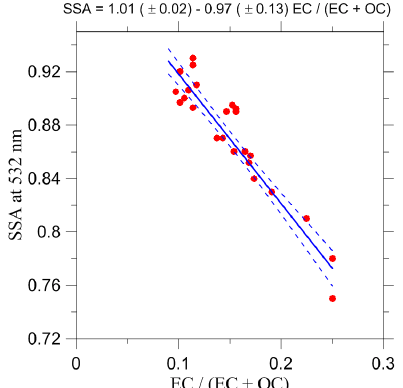
Figure 1. The relationship between the EC/(EC + OC) ratio and SSA at 532 nm. The relationship has been obtained in this study by using the data of aircraft measurements of SSA, BC and PM 2.5 in aging BB plumes [70] (see Figure 9b in ref. [70]). The EC/(EC + OC) ratio has been derived from the measurement data for the Δ BC/ Δ PM2.5 enhancement mass ratio by assuming that the BC measurements were representative of the EC content in BB aerosol and that OC mass fraction of the PM 2.5 was 39% [70]. The solid and dashed blue lines show the linear fit and the 90% confidence intervals.